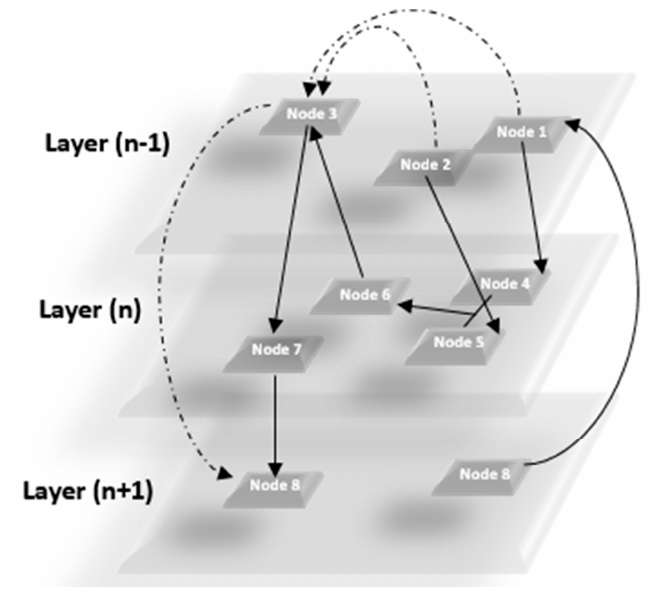
Figure 2. Generic Model of the Multilayered Graph implemented in our package.